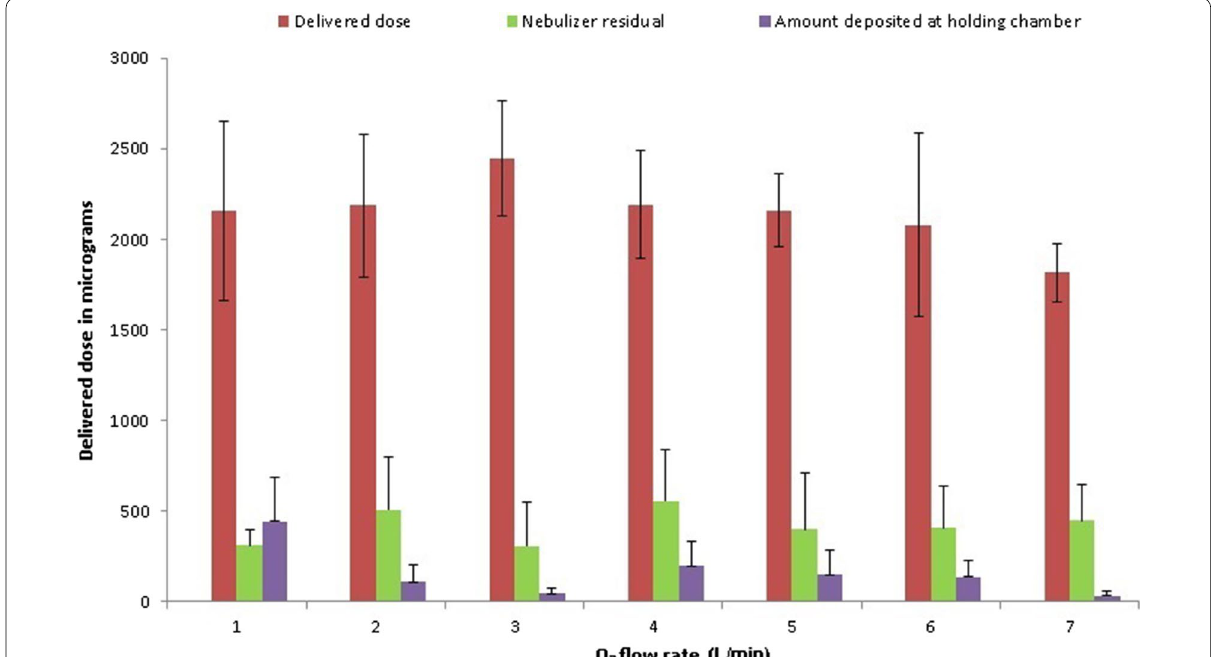
Fig. 2 Fate of supplied doses of salbutamol (the inhalation filter, nebulizer residual, and amount deposited in holding chamber in micrograms) at different oxygen flows using a